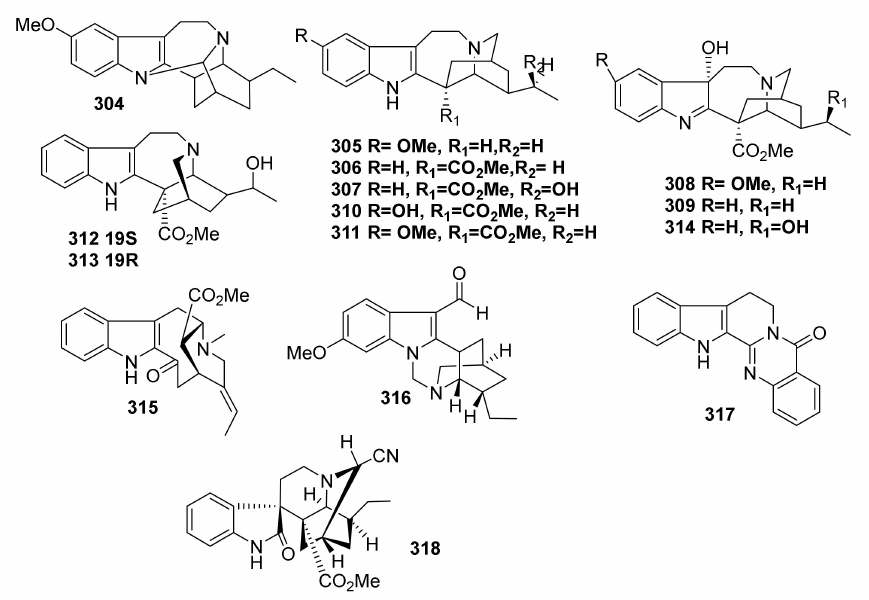
Figure 25. Compounds 304 – 318